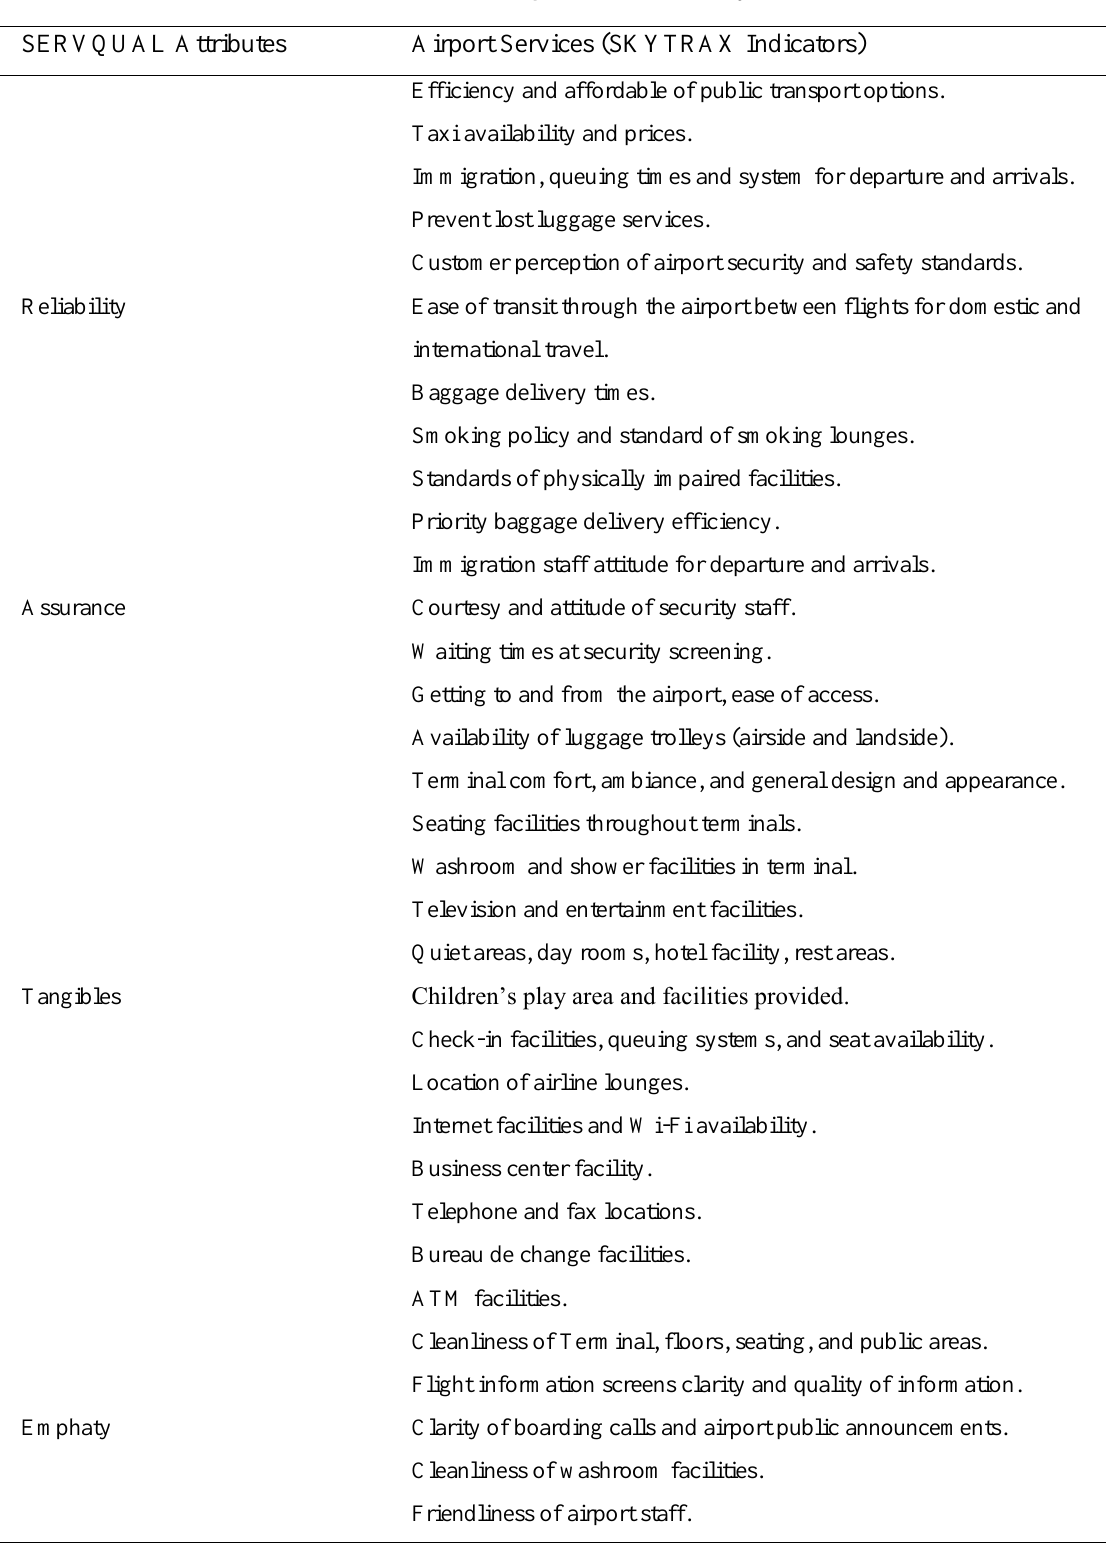
Table 2. Airport Service